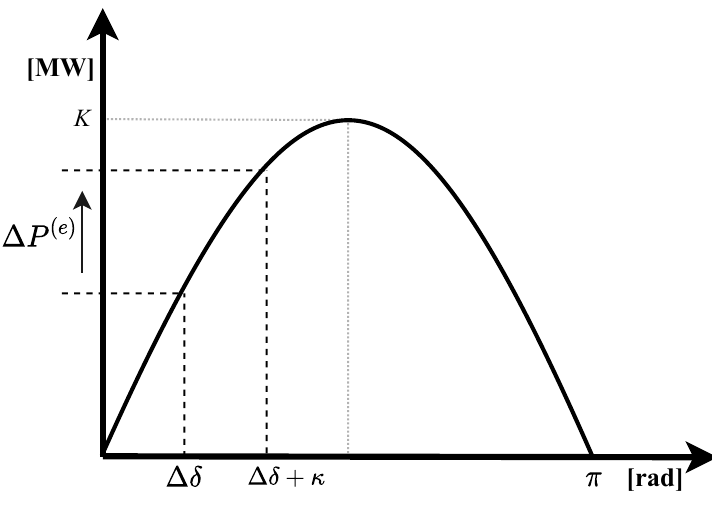
Figure A1. Power angle